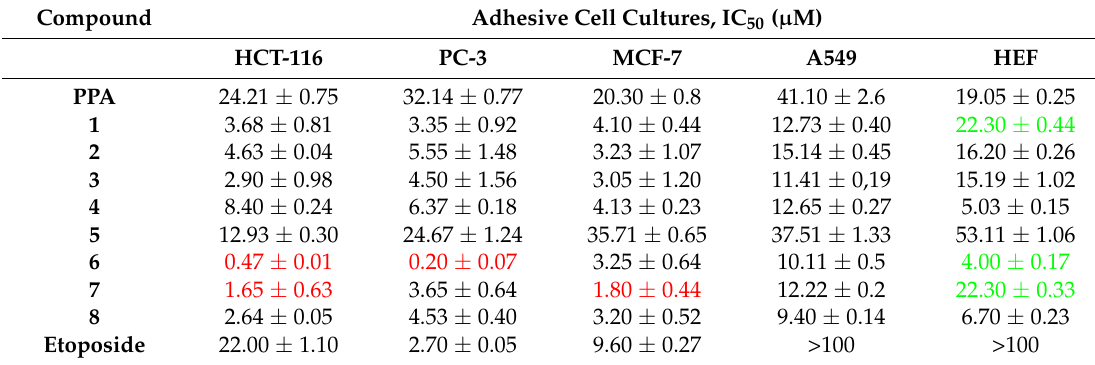
Table 1. IC 50 values for the respective compounds when studied on the adhesive cell lines. Data was expressed as the inhibitory ratio ± SD based on three independent experiments ( n = 3).